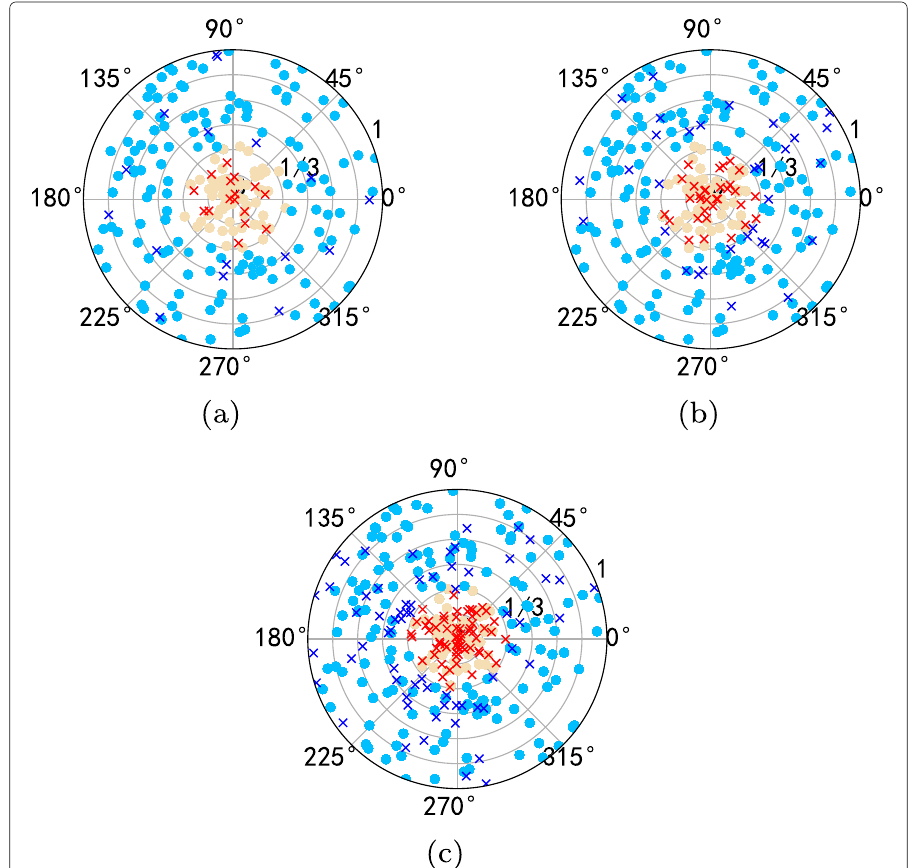
Fig. 5 Entanglement classification for Werner states: In the plots, the radius represents the parameter p , and the angle represents φ . Every single dot represents a Werner state. Yellow dots represent test data that are predicted as ‘untangled’, and light blue dots represent test data predicted as ‘entangled’. Cross represent training data, and red cross for untangled states, blue for entangled states. In all three figures we used the same 400 test data, half of which are entangled and the other half are untangled. Half of the training data are entangled states and the other half are untangled states. a 32 test data are used, all are kept as sublabels. b 64 test data are used, all are kept as sublabels. c 128 test data are used, and only 64 of them are used as